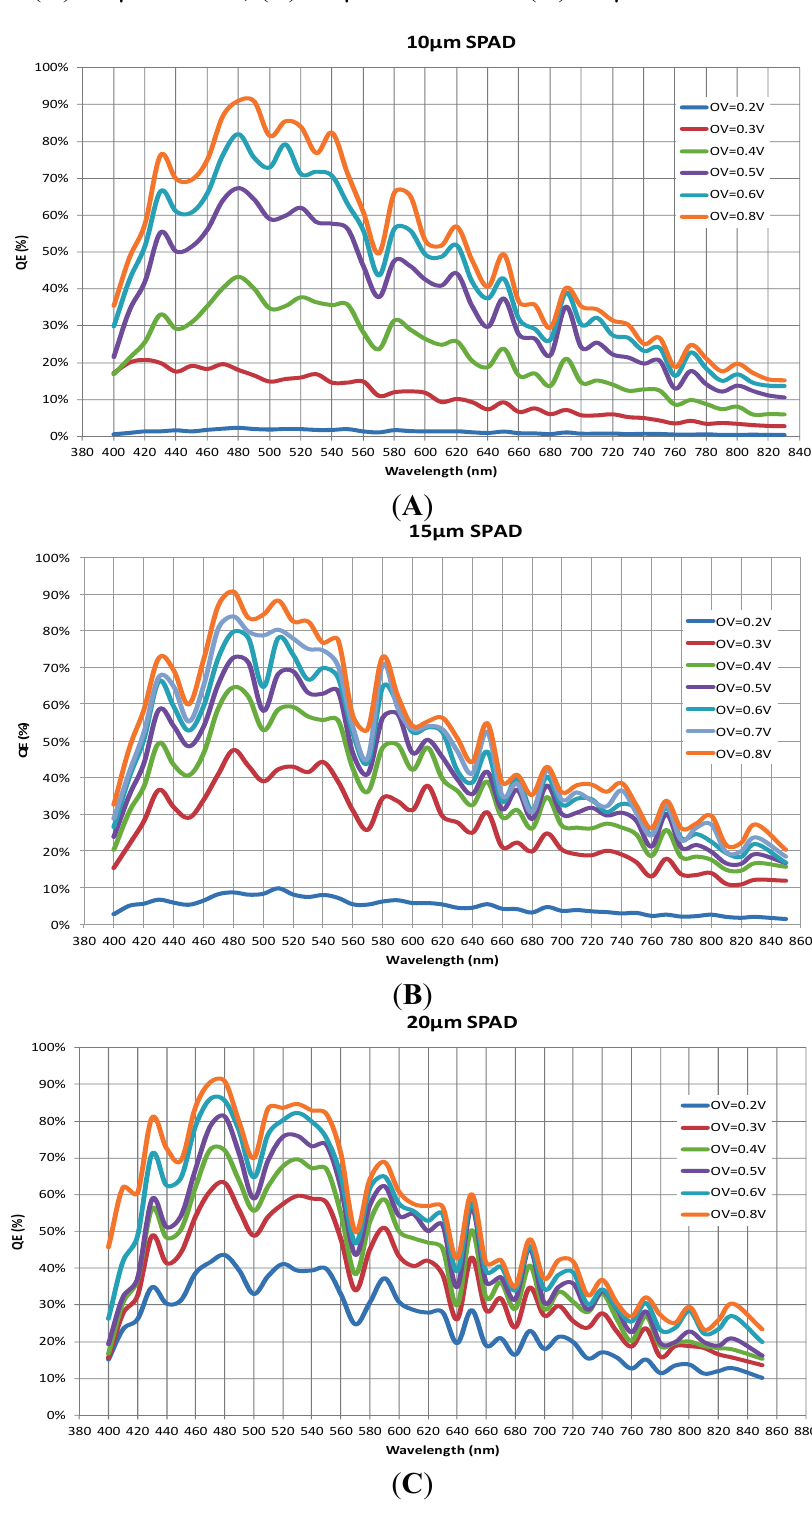
Figure 7. Quantum efficiency of the three SPADs as a function of wavelengths and overvoltages. ( A ) 10 µm SPAD; ( B ) 15 µm SPAD and ( C ) 20 µm